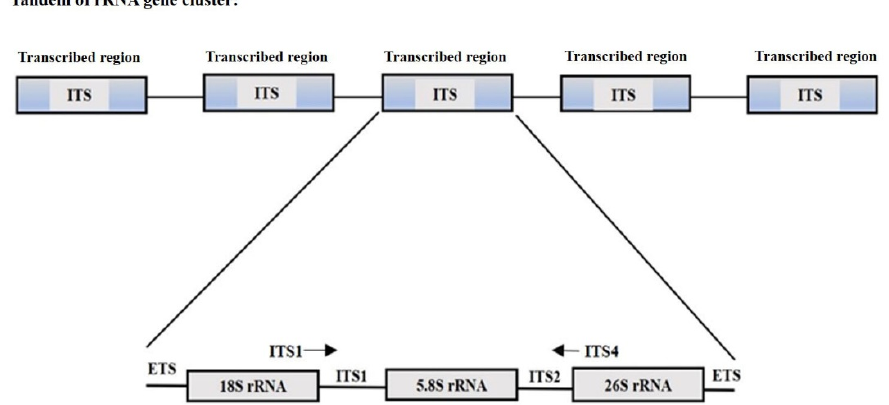
Figure 1. Schematic representation of nrDNA region with ITS region’s primer (ITS1/ITS4) localization (arrows). ETS (External transcribed spacers).